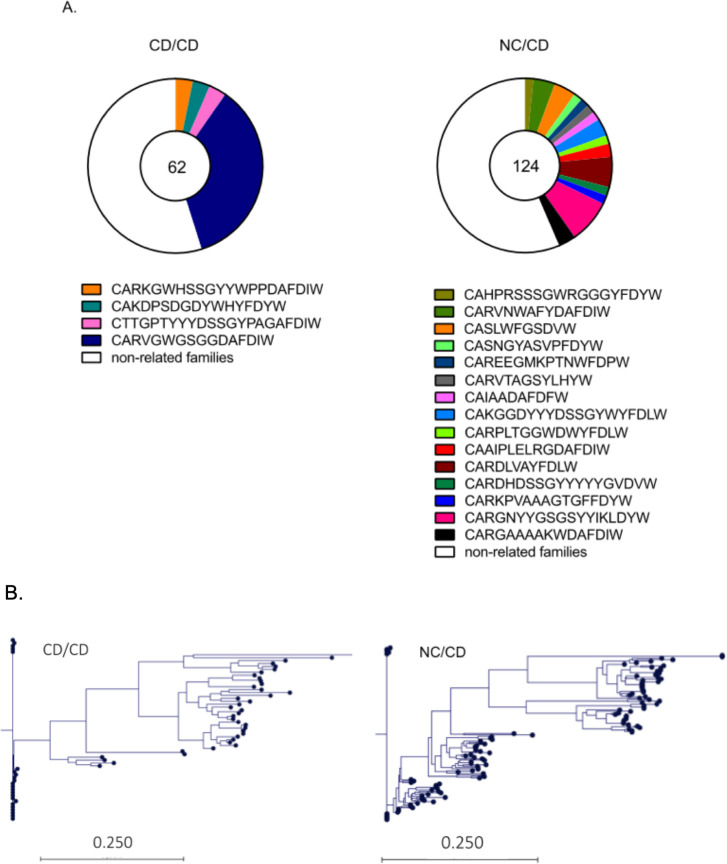
Antibody clonal families and their phylogeny within gp140+-specific IgG+ hu-B cells.(A) Pie charts of clonal family representation were constructed from the IgH sequences and CDR3 segment of sorted gp140+-specific IgG+ hu-B cells. The white slice represents sequences that appeared only once. The colored slices represent clonally related sequences, for which each color accounts for a different IgH clone. The numbers in the pie charts represent the number of mAbs evaluated. Human B cells were considered to belong to the same clone on the basis of identical V, D, and J gene segment usage and CDR3 length for both heavy- and light-chain Ig genes. (B) Phylogenic trees were generated after sequence alignment using CLC Main Workbench 7 software (v7.0) with default parameters. The relationship between sequences was determined via the neighbor-joining method. Each tip represents a BCR heavy chain sequence. The scale bar represents the genetic distance (expected changes per nucleotide site).